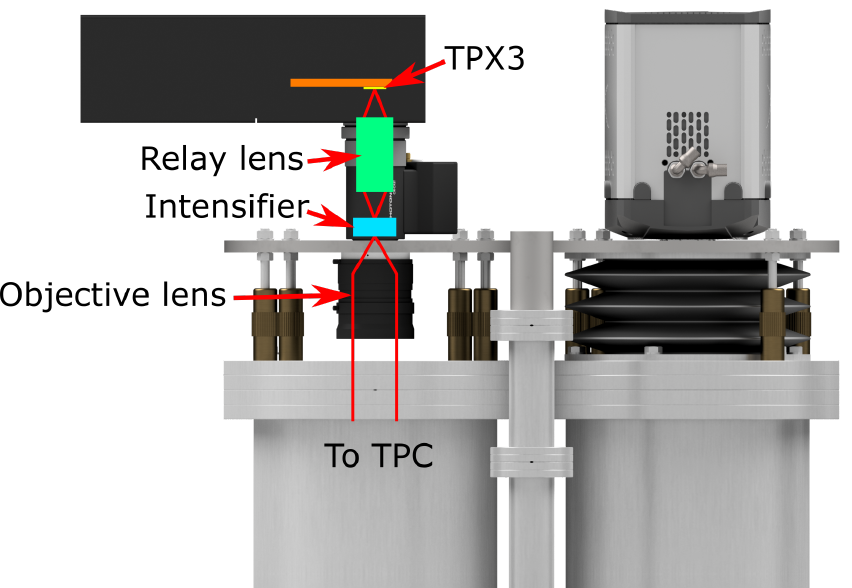
Figure 3. The TPX3Cam detection principle. The light-tight bellow around the objective lens has been omitted for clarity. The objective lens focuses light generated in the THGEM holes onto a photocathode at the front of the image intensifier. The intensifier provides a photon gain of ≈ 10 6 photons/photon. A relay lens directs the intensified light signal onto a light-sensitive sensor which is bump-bonded to a TPX3